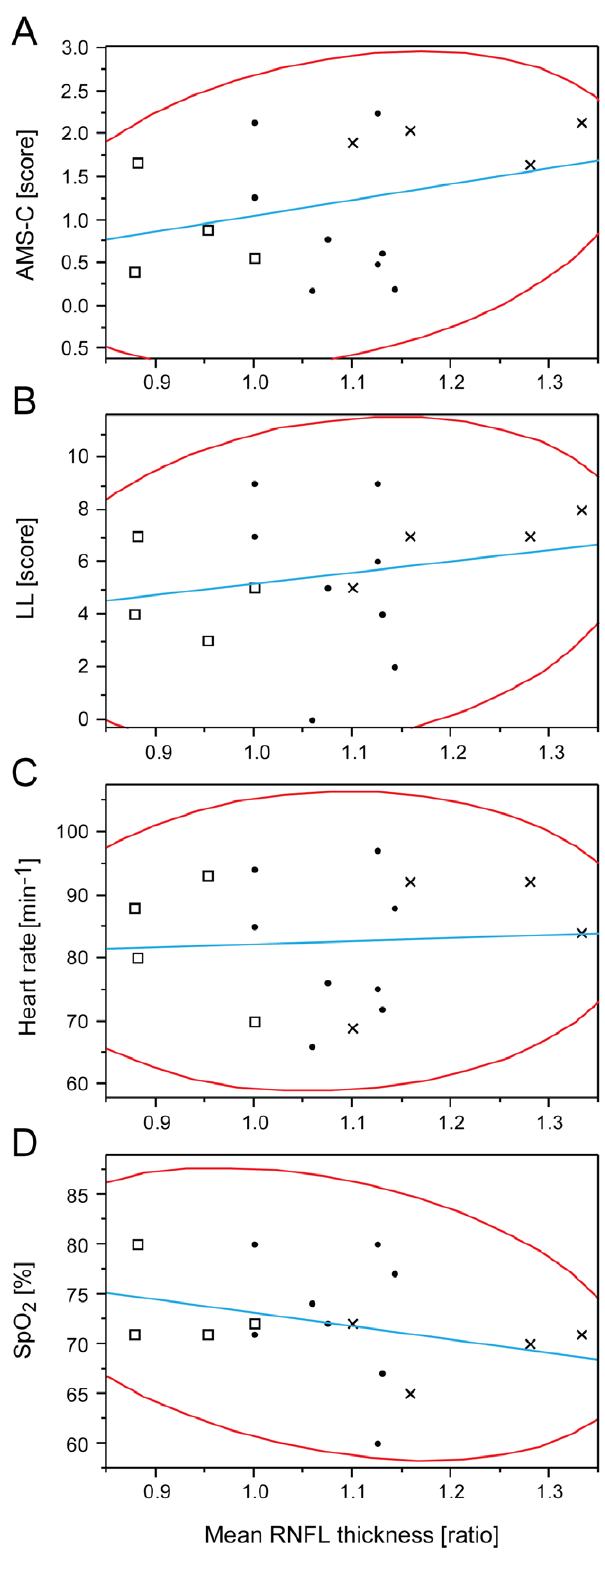
Figure 4. Correlation of optic disc edema with AMS and clinical parameters during high altitude exposure. Optic disc edema does not correlate with AMS-c, LL, HR or SpO 2 . Representative correlation analyses between mean retinal nerve fiber layer (RNFL) thickness ratios and (A) AMS-c (r=0.30; CI= 2 0.23 to 0.69; p =0.25), (B) LL